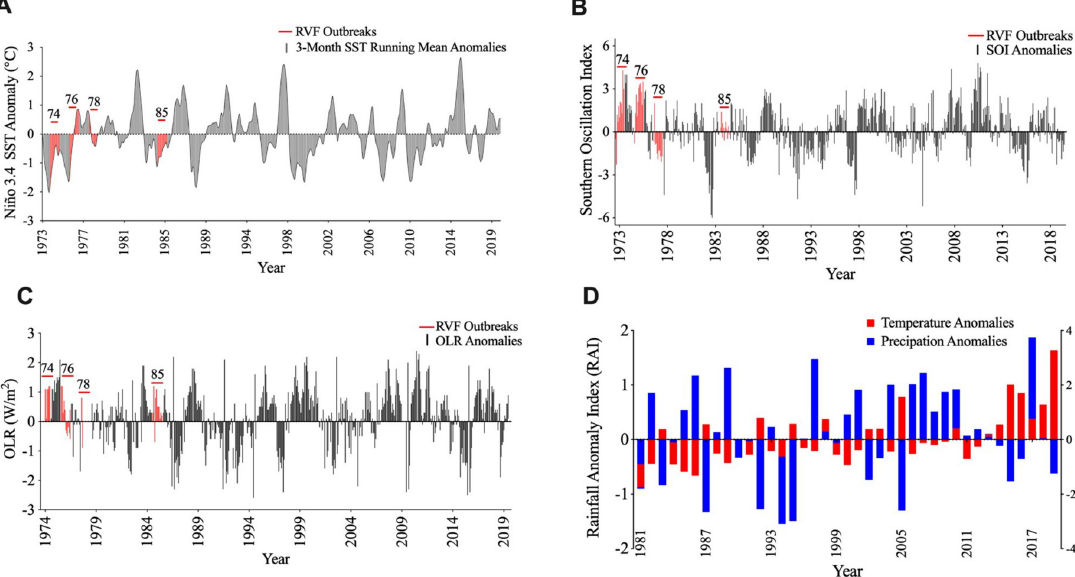
Fig 2. El Ni ñ o-Southern Oscillation indices. (A) Equatorial pacific (Ni ñ o 3.4) sea surface temperature anomalies (1973–2019). (B) Southern Oscillation Index (SOI) anomalies (1973–2019). (C) Outgoing long wave radiation anomalies (1974–2019). (D) Precipitation anomalies for Zambia (1981–2019) indicating wet (0–2) to extremely wet ( > 2)